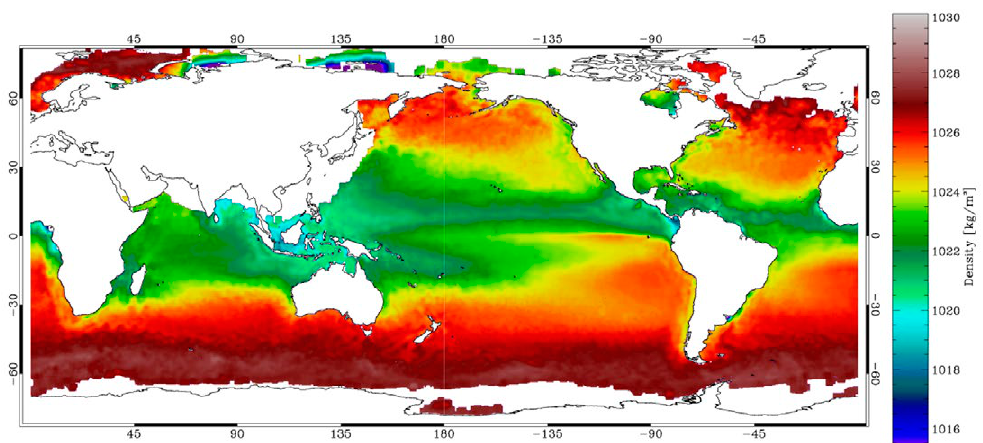
Fig. 13. – Map of average surface densities at global scale, derived from SMOS OI data and OSTIA SST, for the period January-March 2010.